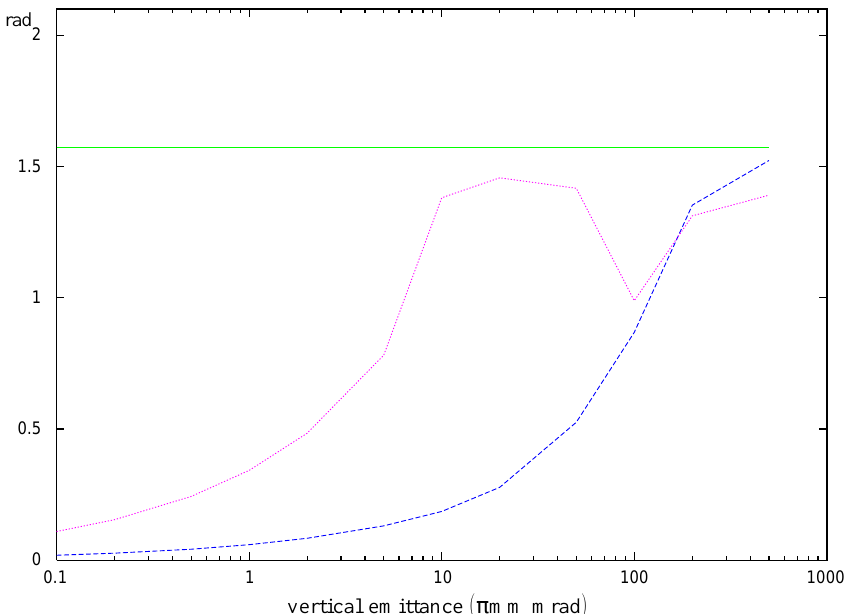
FIG. 6. (Color) SPRINT opening angles for a beam with normalized vertical emittance of up to 400 p mm mrad in HERA at 803.9 GeV (cid:1) c (purple dotted line) and at 819 GeV (cid:1) c (blue dashed line). The green horizontal line indicates an average opening angle of p (cid:1) 2 and therefore zero average